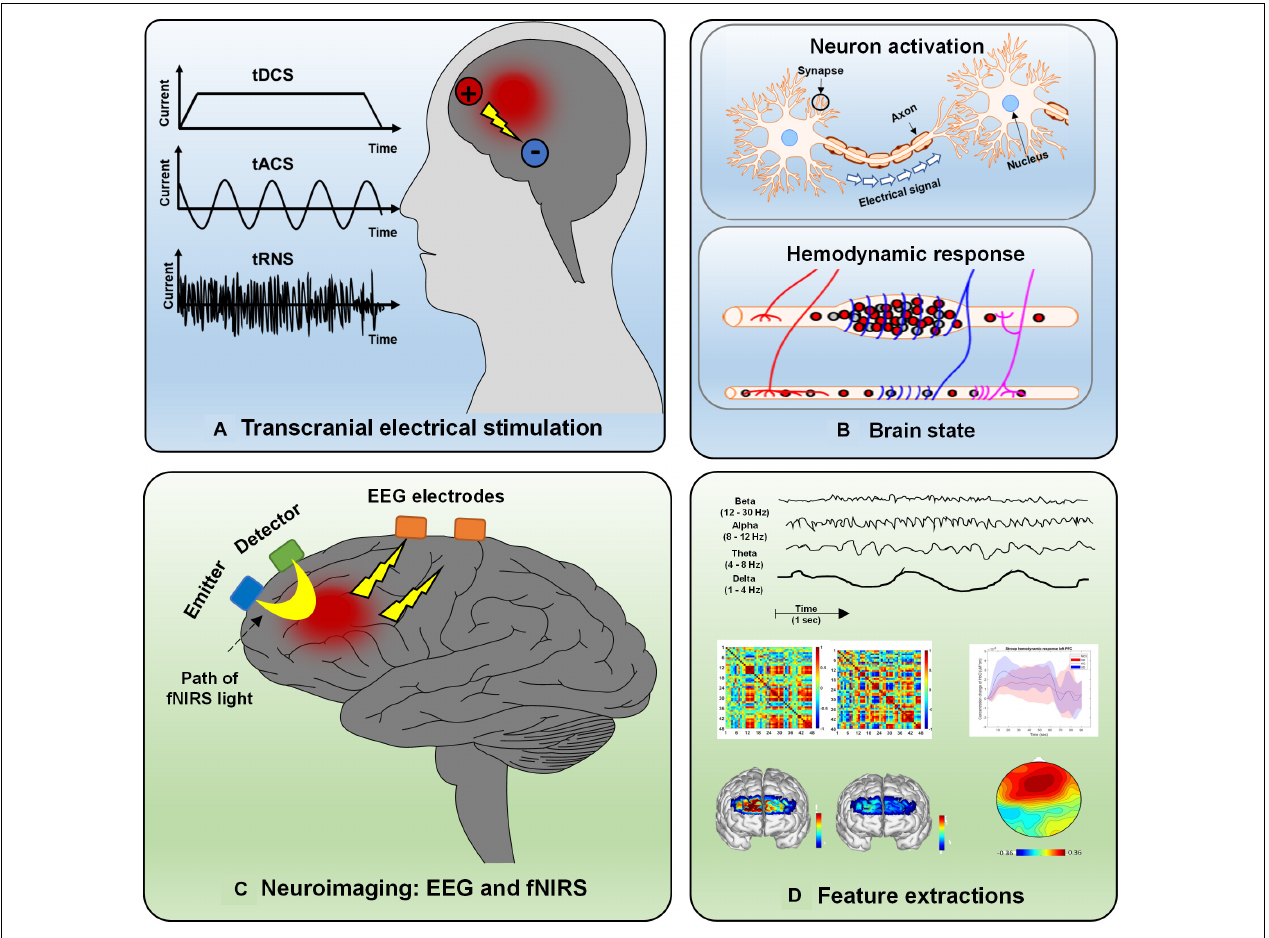
FIGURE 2 | Overview of electrical stimulation, EEG, fNIRS, and feature extraction: (A) Three types of electrical stimulation (tDCS, tACS, and tRNS), (B) hemodynamic response caused by neural activity, (C) principle of EEG and fNIRS, and (D) various features extracted from neurological